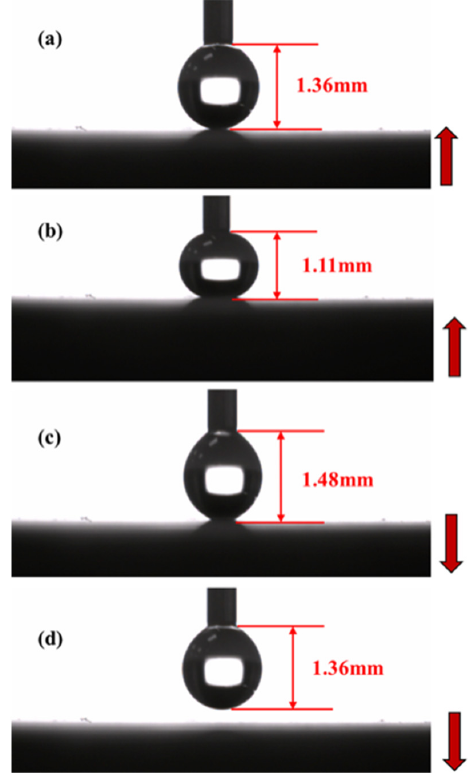
Figure 11. Photographs of the contact and departure process of water droplet ( a ) slightly contacted with the superhydrophobic surface, ( b ) compressed by the surface, ( c ) stretched by the moving surface, and ( d ) departed from the surface. The arrows show the movement directions of the surface.